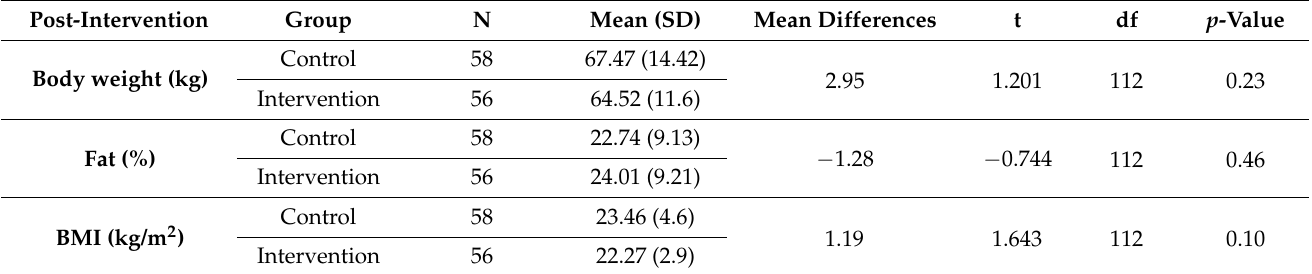
Table 4. Post intervention comparisons of anthropometric variables between the control and inter- vention